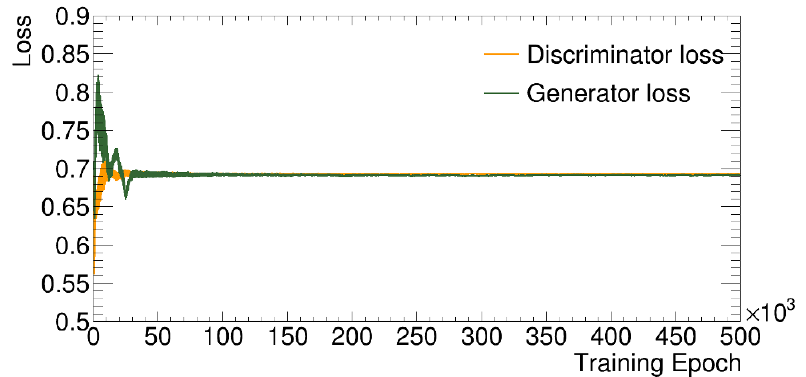
Figure 2 . Evolution of the discriminator and generator loss at particle level as a function of the training epoch.